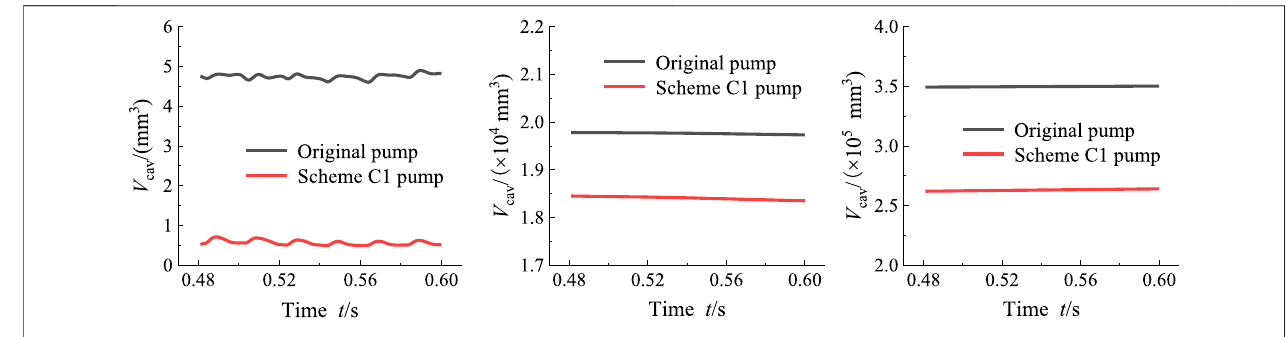
FIGURE 10 | Cavitation volume under different NPSH a